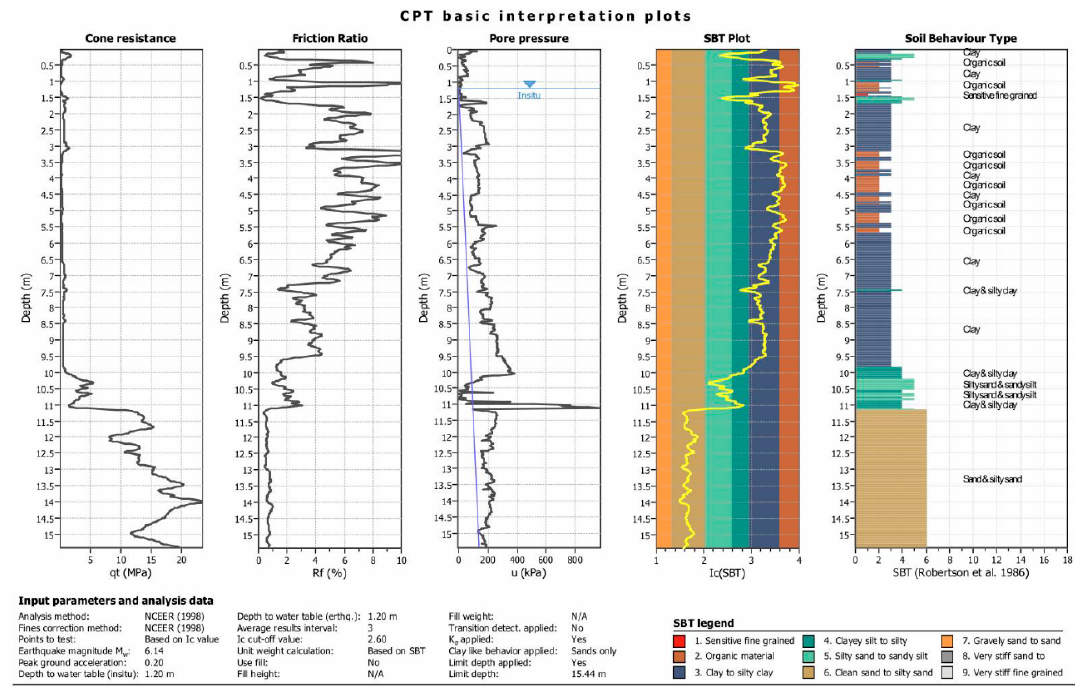
Figure 2. Static cone penetration test results.